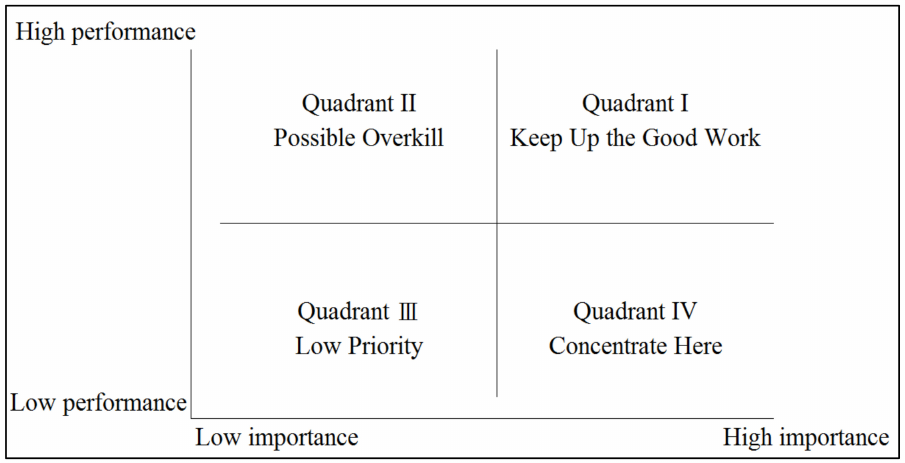
Figure 1. Traditional importance–performance grid.